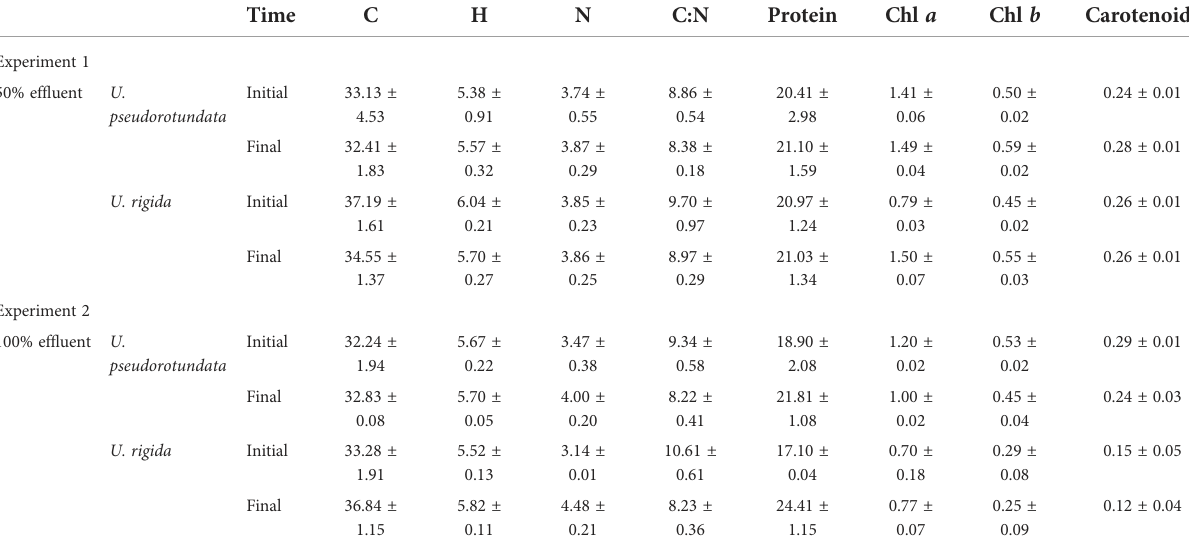
Table S6) and an absence of signi fi cant differences between species. Both species showed a signi fi cant increase in nitrogen and protein content when cultivated in 100% ef fl uent (Tukey post hoc test, p < 0.001) while a signi fi cant reduction was observed in the C:N ratio between the beginning and end of the experiment (Tukey post hoc test, p < 0.001). The hydrogen content were not affected by the TABLE 3 Elemental and biochemical composition of the dry biomass of U. pseudorotundata and U. rigida grown in different concentrations of fi sh pond ef fl uent (experiment 1: 50% and experiment 2: 100%). Time C H